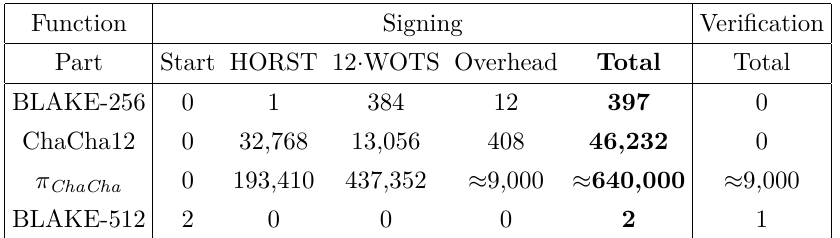
Table 1: Hash evaluations per SPHINCS-256 signature: Overhead is the WOTS signature of the previous tree root without authentication path calculations. Function Signing